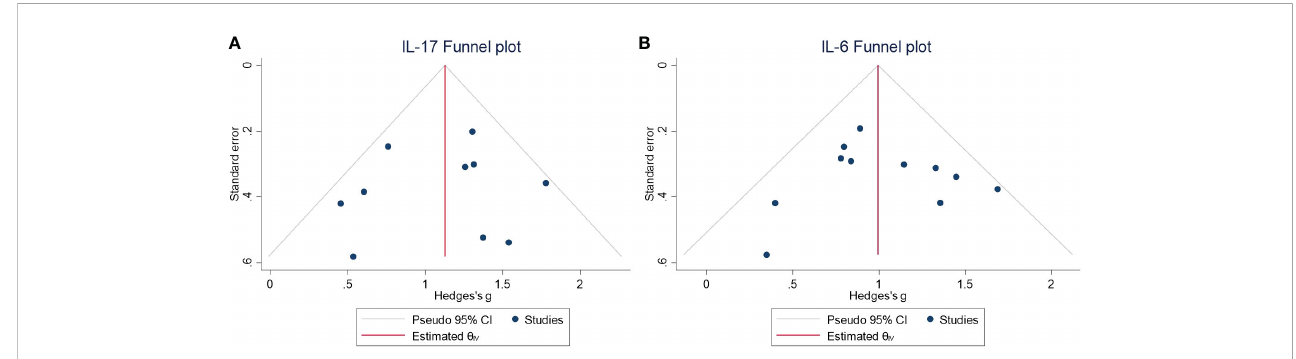
FIGURE 4 (A) Funnel plot for the meta-analysis of the IL-17 level in the CSF of NMDAR-E vs. control. (B) Funnel plot for the meta-analysis of the IL-6 level in the CSF of NMDAR-E vs. control. CSF, cerebrospinal fl uid; NMDAR-E, anti-N-methyl-D-aspartate receptor encephalitis; IL, interleukin; CI, con fi dence